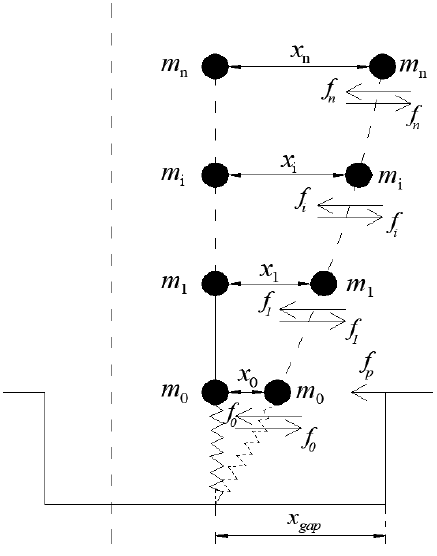
Figure 3. Model of the base-isolated structure with lead-rubber bearing.